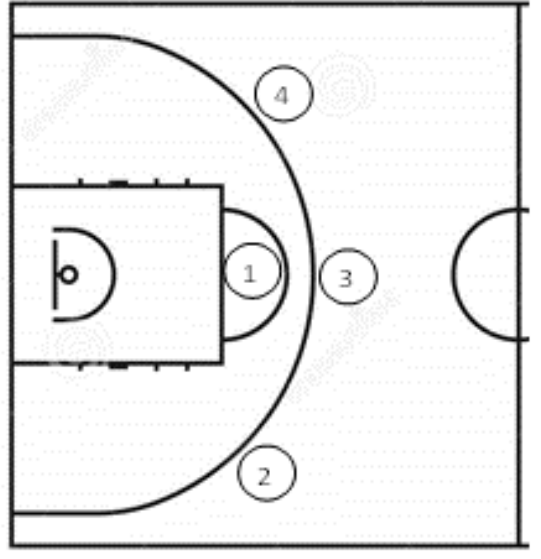
Figure 1. Shooting positions. Legend: 1 — free throw line; 2 — 3 points line 45°; 3 — 3 points line 90°; 4 — 3 points line 135°.